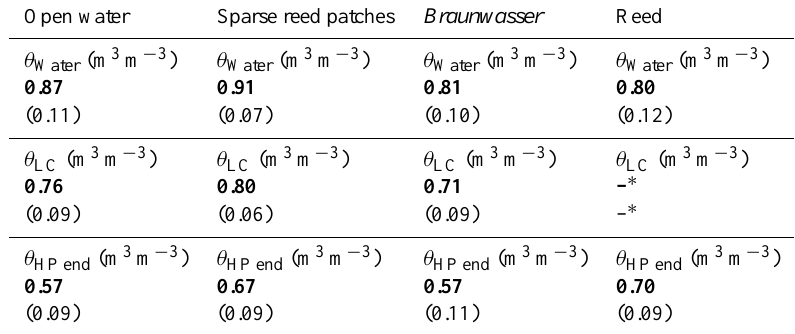
Table 3. Ecotope-specific volumetric water content for water θ Water , at the lutocline θ LC , and at the HP submersion end θ HP end . Open water Sparse reed patches Braunwasser Reed